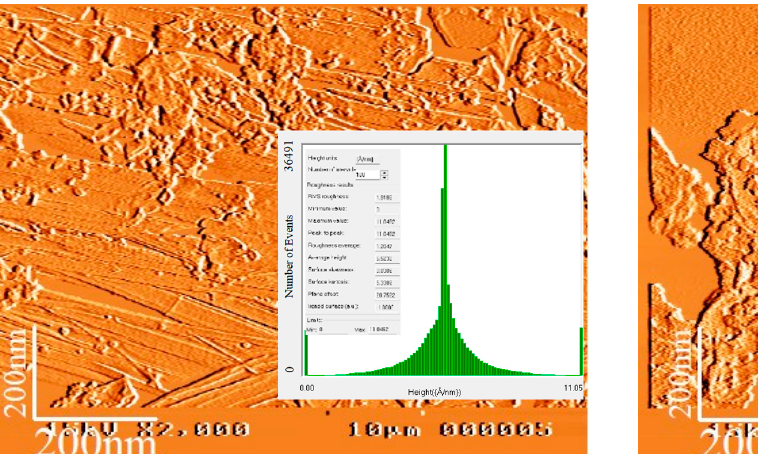
Figure 5. AFM images and roughness studies of [PoPDA] TF .